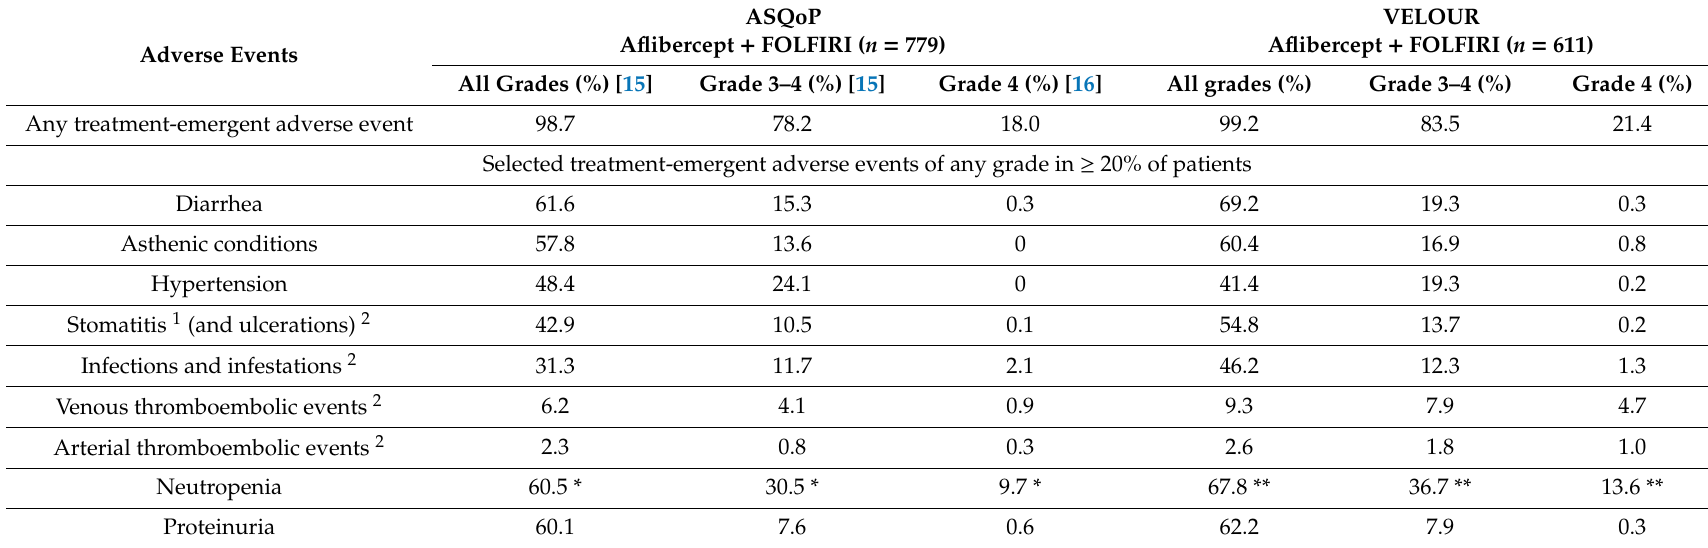
Table 2. Safety data from the fifth interim analysis of ASQoP compared with VELOUR [15,16].